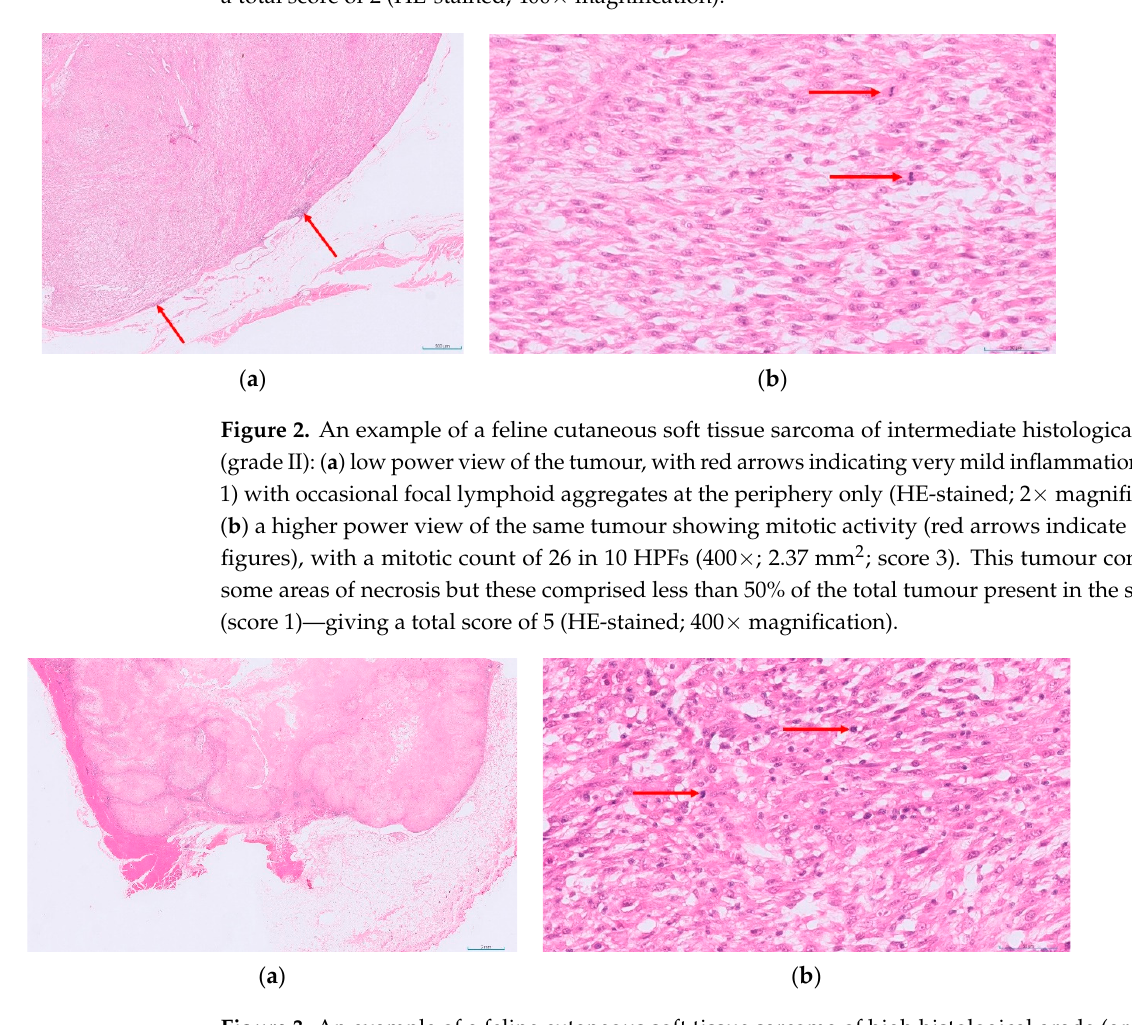
Figure 1. An example of a feline cutaneous soft tissue sarcoma of low histological grade (Grade I): ( a ) low power view of the tumour within haired skin, with focal ulceration (HE-stained; 1× magnification); ( b ): higher power view of the same tumour. This tumour had very mild inflammation (score 1), a mitotic count of 4 in 10 HPFs (400×; 2.37 mm 2 ; score 1) and no necrosis (score 0)—giving a total score of 2 (HE-stained; 400× magnification).